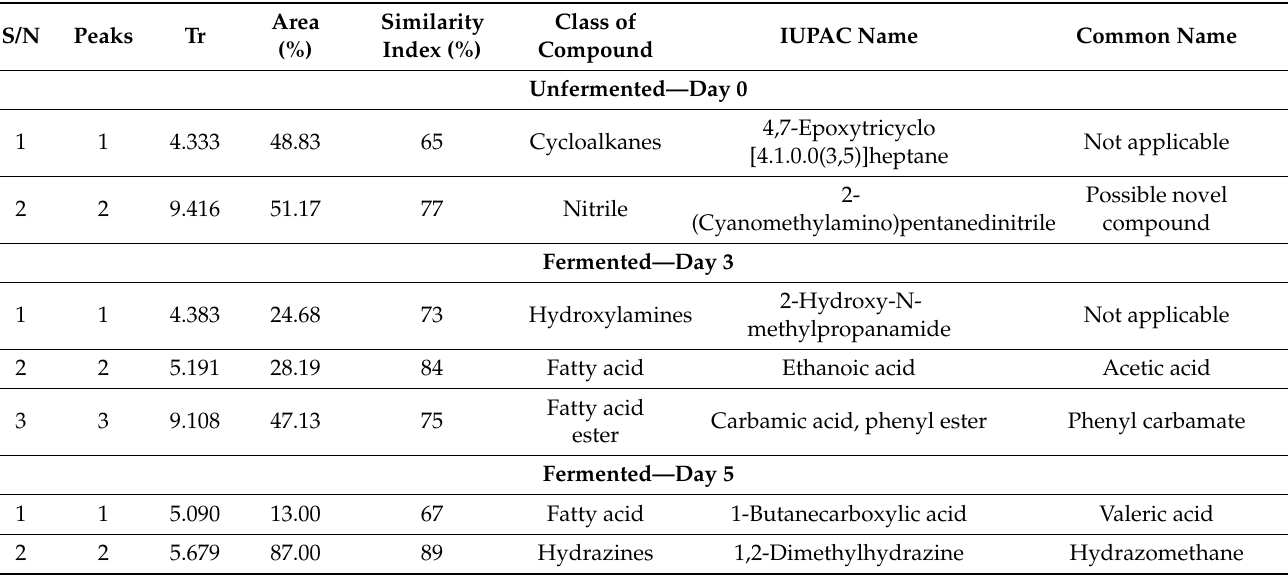
Table 5. Compounds present in the gas chromatography-mass spectrometry (GC-MS) analysis of the unfermented leaves extract of S. monostachyus